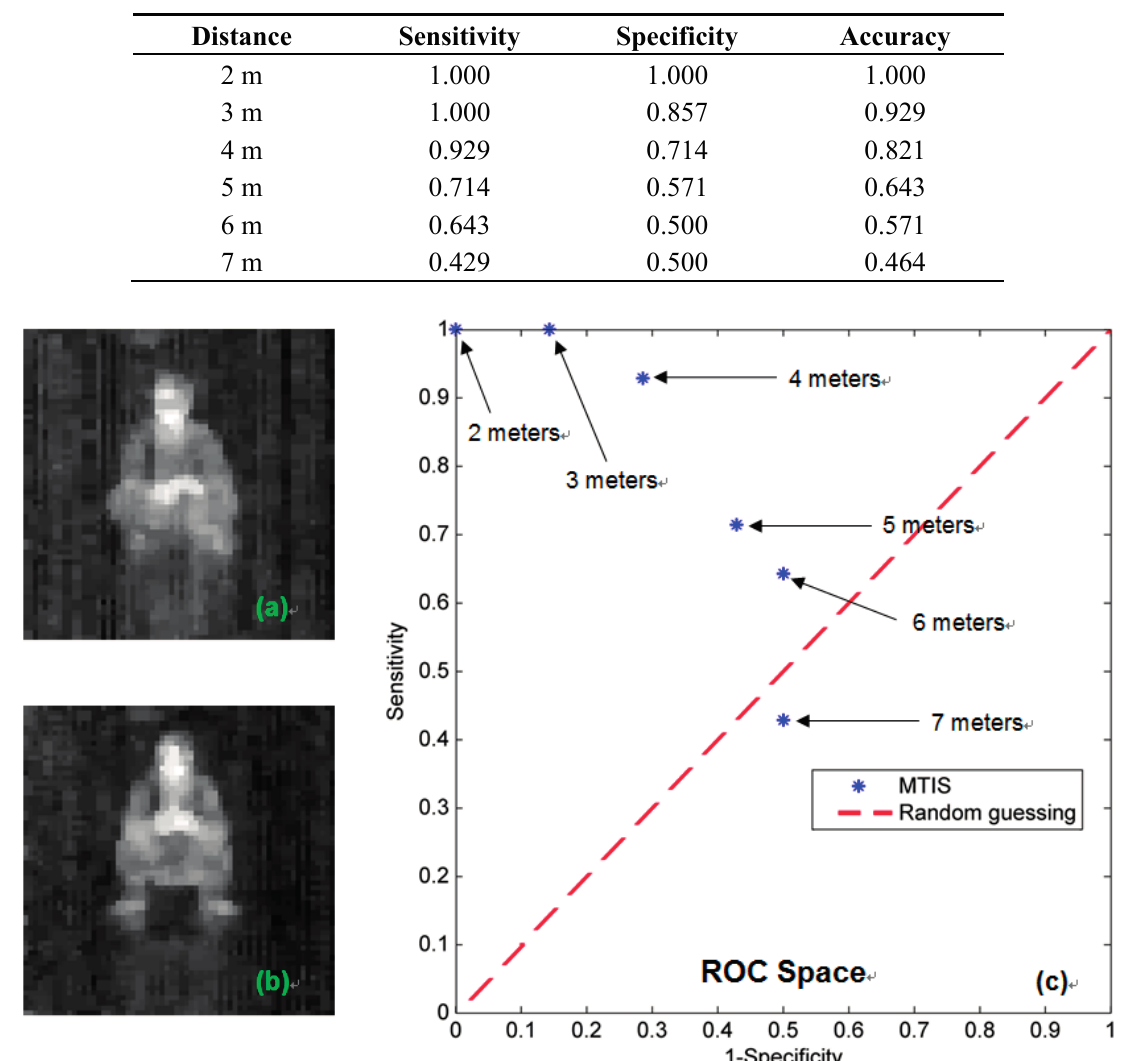
Table 1. Sensitivity and specificity analysis of pattern recognizing ability of MTIS.